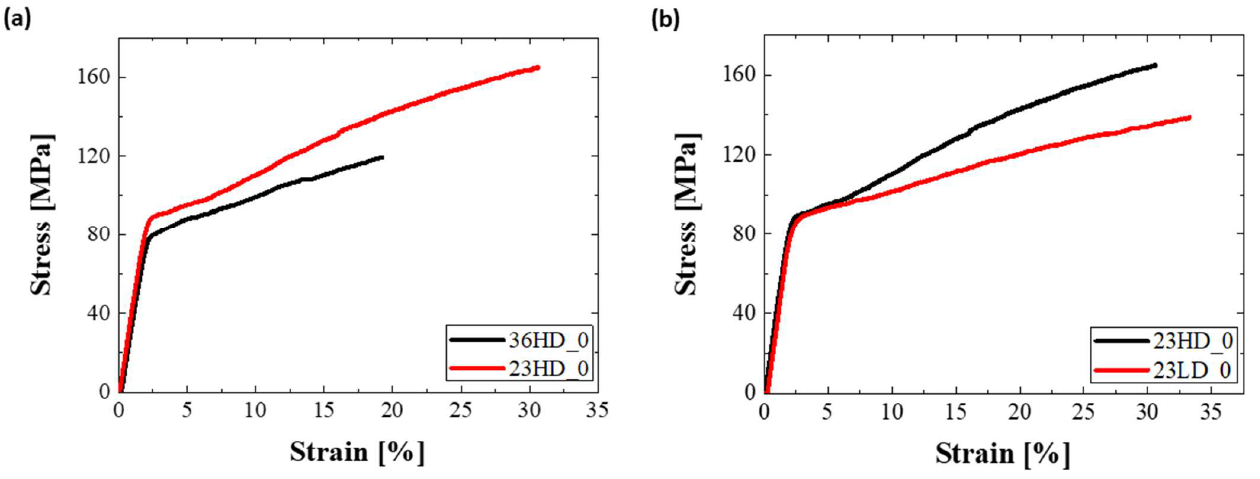
Figure 8. Tensile curves of unetched samples: effect of PET substrate ( a ) Thickness and ( b ) Pore density on mechanical behavior.